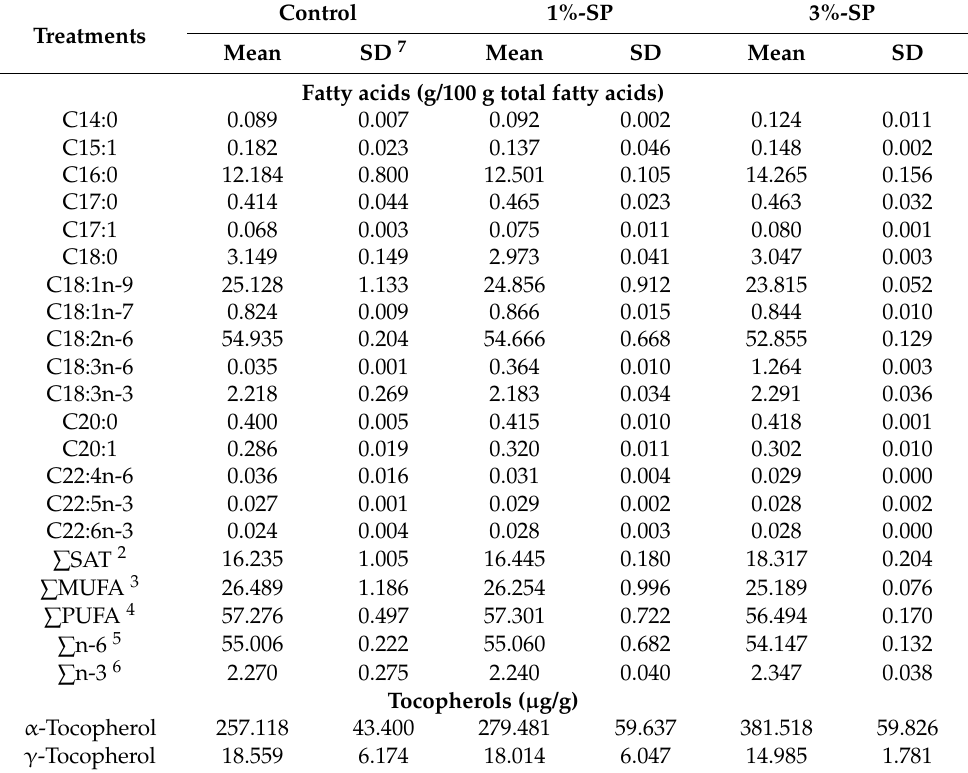
Table 2. Fatty acid composition and tocopherol content of the experimental diets 1 .